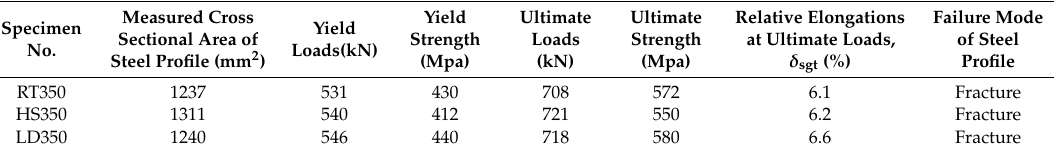
Table 6. Primary results for specimens in the second test group.